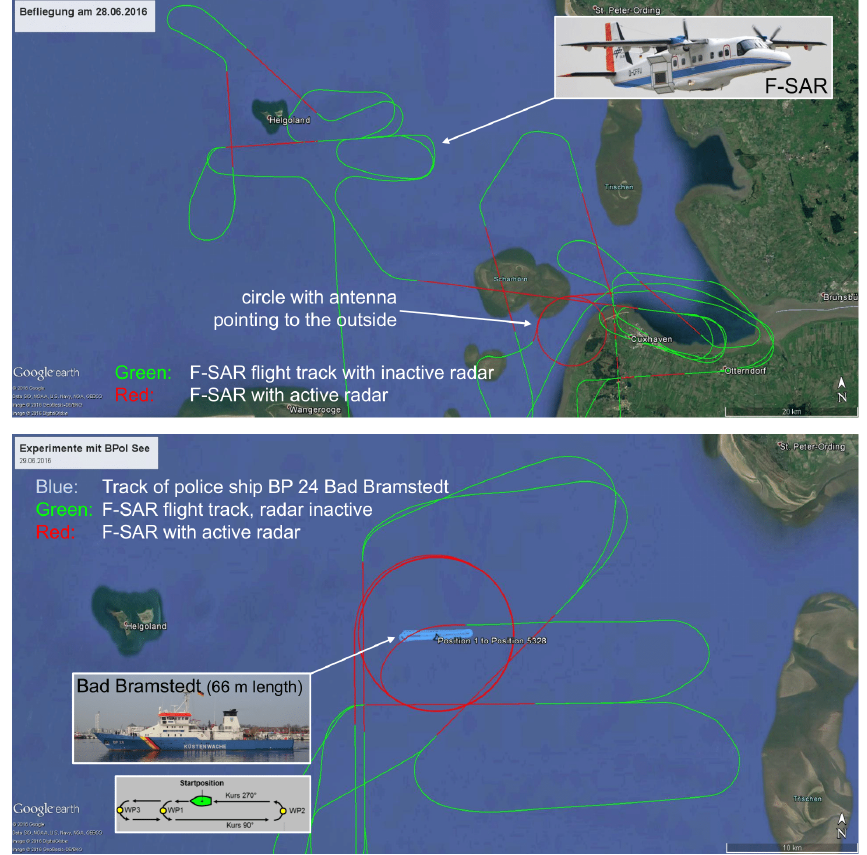
Figure 21. Flight tracks flown during the two-day North Sea campaign (top: day 1; bottom: day 2).